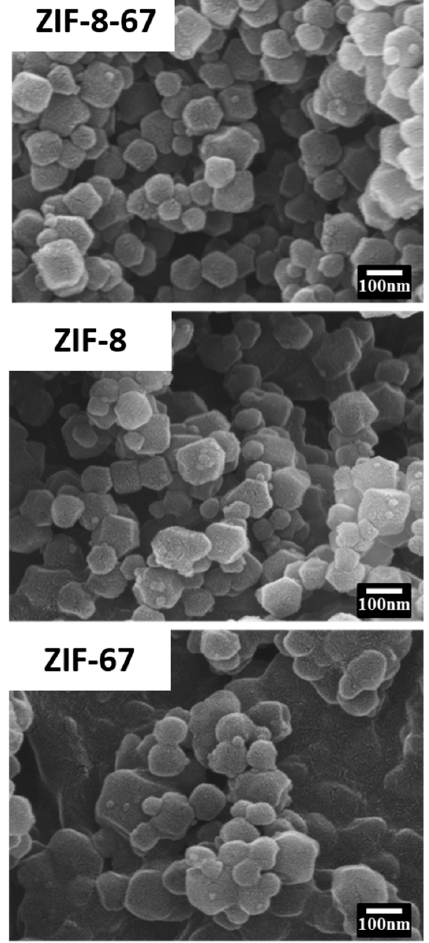
Figure 2. SEM images of ZIF-8, ZIF-67, and ZIF-8-67.